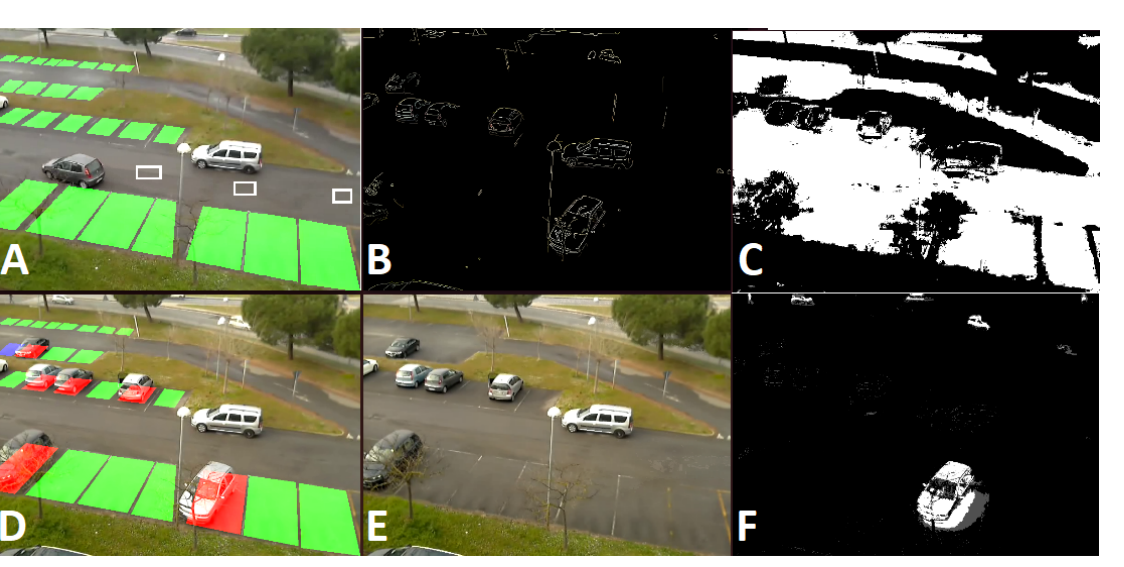
Figure 2. ( A ) RoI for a set of parking lots are set up manually with the help of a graphic tool. Small rectangles on the driveway define the samples for asphalt detection ( B ) The output of the Canny edge detector ( C ) White regions represent areas where asphalt is detected ( D ) Current input image with augmented reality displaying the status ( E ) Background image ( F ) Frame differencing to detect major status